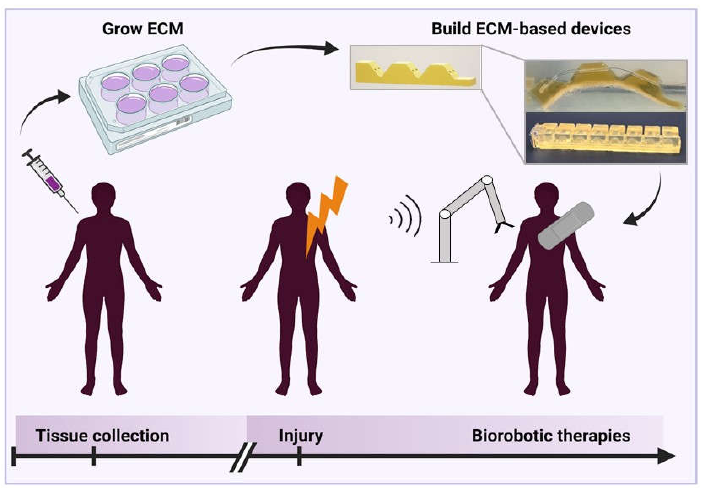
Figure 8. A proposed vision for the future of biorobotic devices in which autologous protein-based (ECM) materials are maintained and engineered into patient specific and disease injury specific devices to be used at the time of injury.